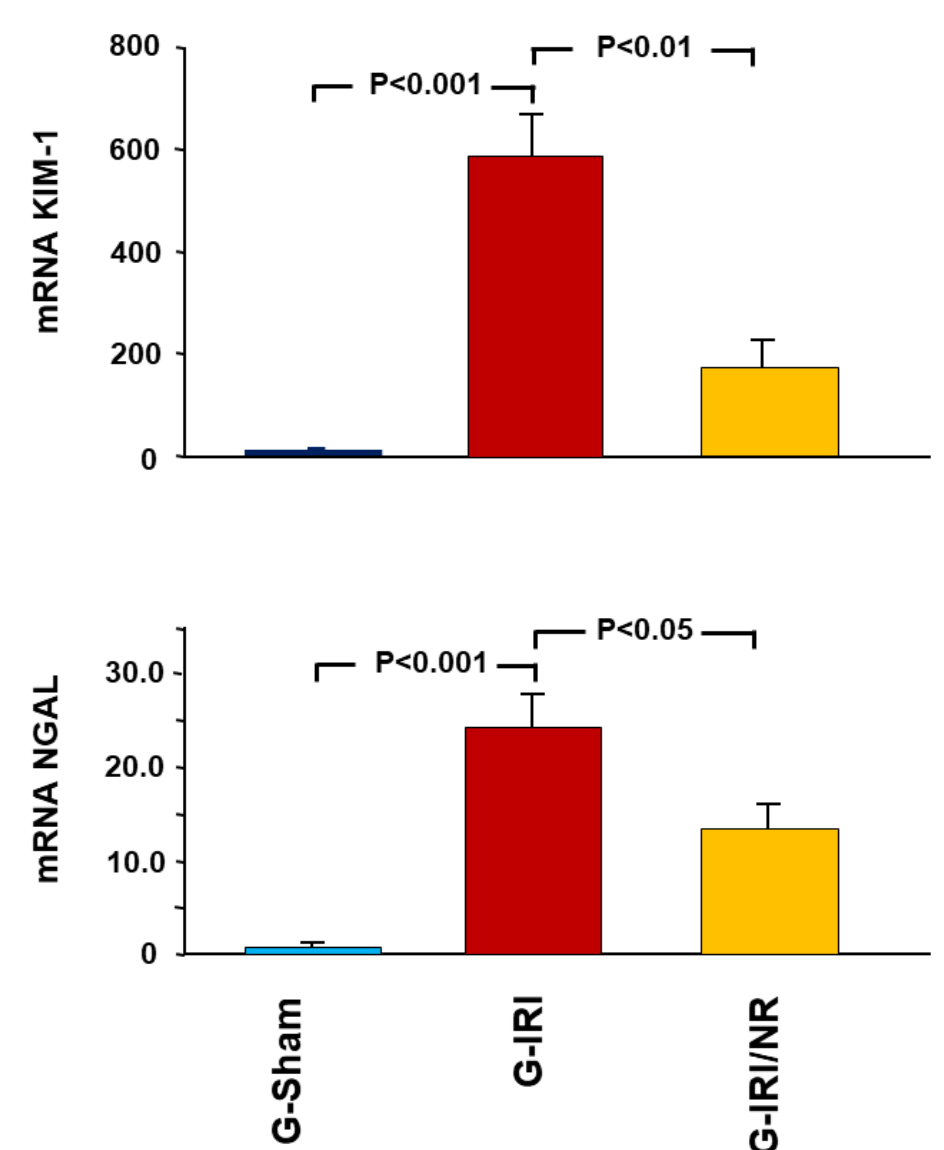
Figure 2. Gene expression of two markers of acute renal injury (KIM-1 and NGAL) in all groups. Values represent mean ± SEM.